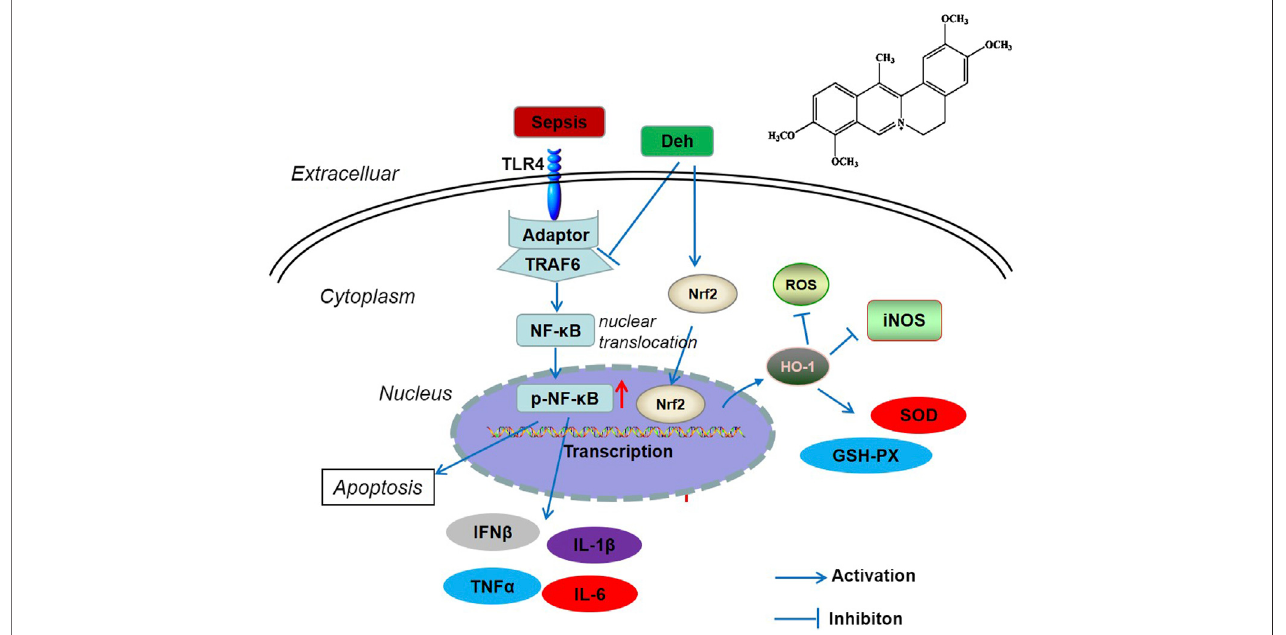
FIGURE 7 | The scheme of Deh mediated myocardial protective effects against sepsis. LPS was recognized by TLR4 and then activated TRAF6 mediated NF- κ B phosphorylation. The phosphorylated NF- κ B translocated from the cytoplasm into the nucleus and promoted the transcription of in fl ammatory factors. Once Deh was administered, TRAF6 was in inhibited and the NF- κ B mediated in fl ammation was also attenuated. Moreover, Deh treatment promoted Nrf2 nucleus translocation. Nrf2 promoted HO-1 expression, which induced enhanced anti-oxidative meidators (including SOD, GSH-PX) and inhibited iNOS and ROS level.